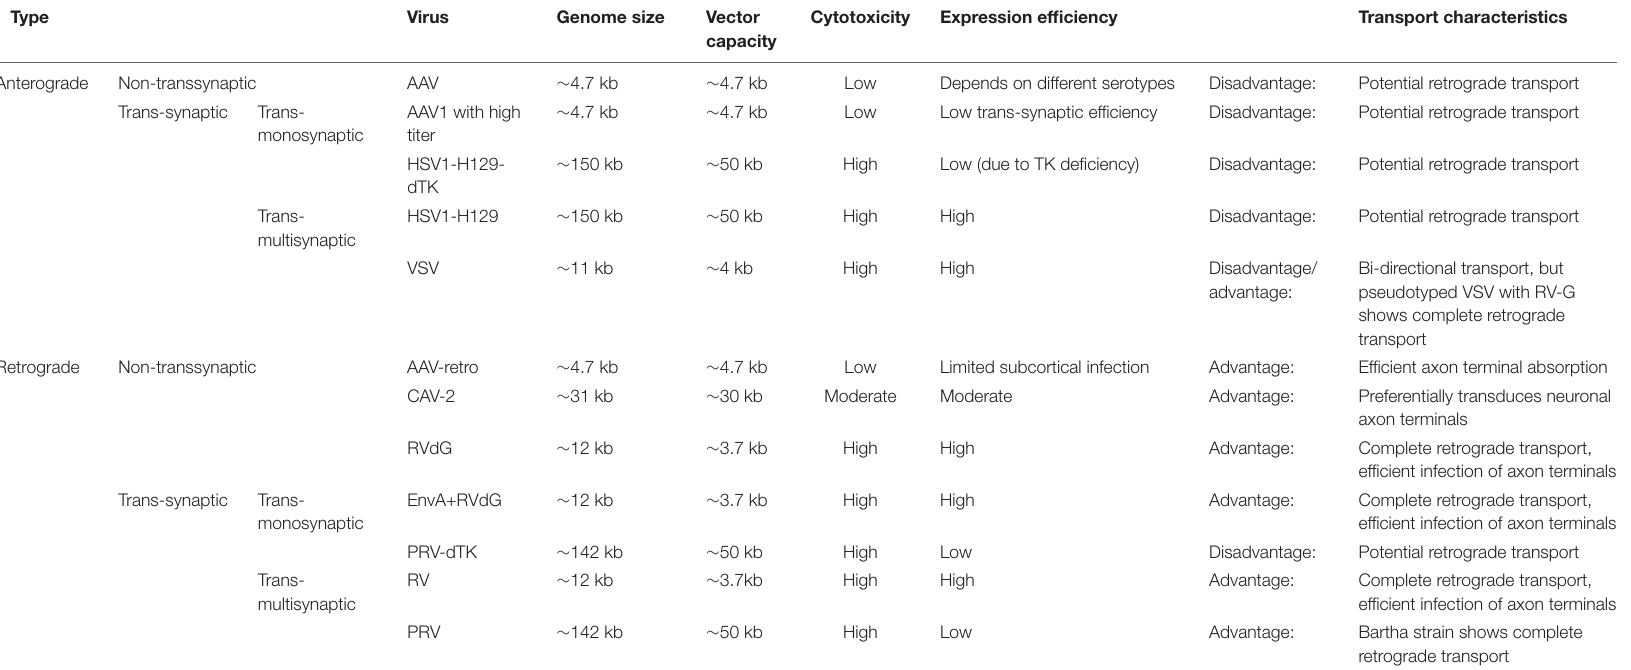
TABLE 1 | Properties of commonly used viral vectors in neural circuit